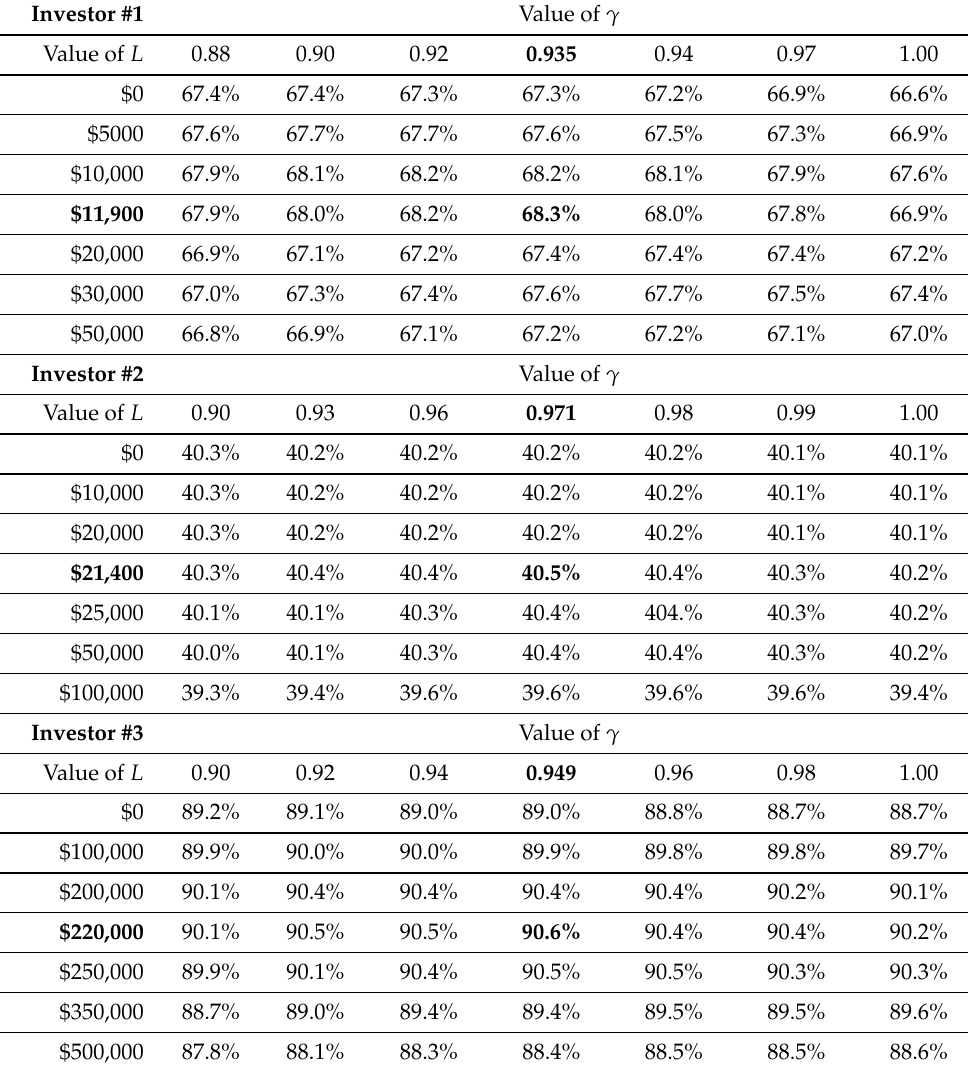
Table 9. The effect of varying the values of L and γ from their optimal (in bold) values on the solvency probability for each of our three example investors.